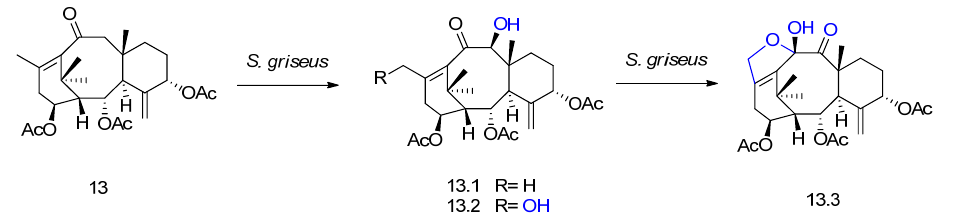
Figure 14. Biotransformation of compound 13 by Streptomyces griseus and its derivatives 13.1 , 13.2 , and 13.3 [59].